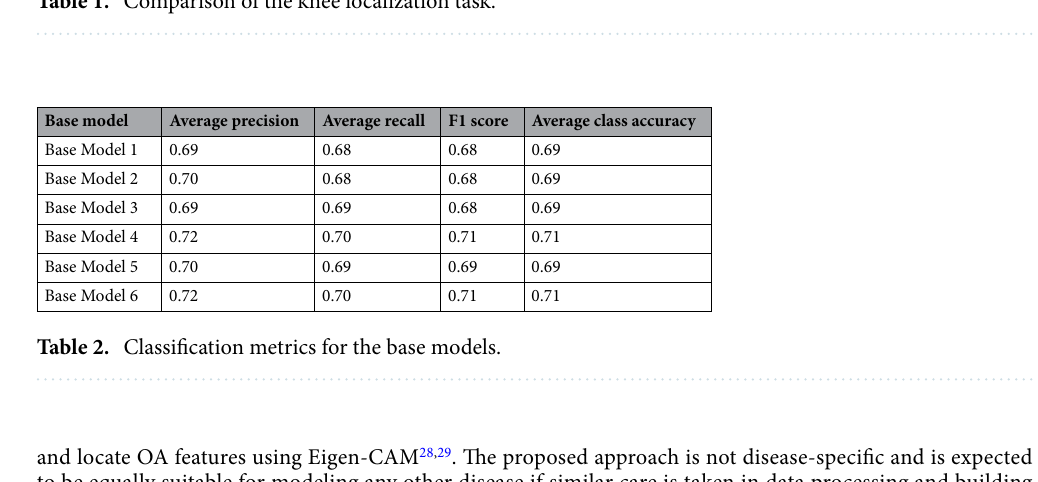
Table 1. Comparison of the knee localization task.